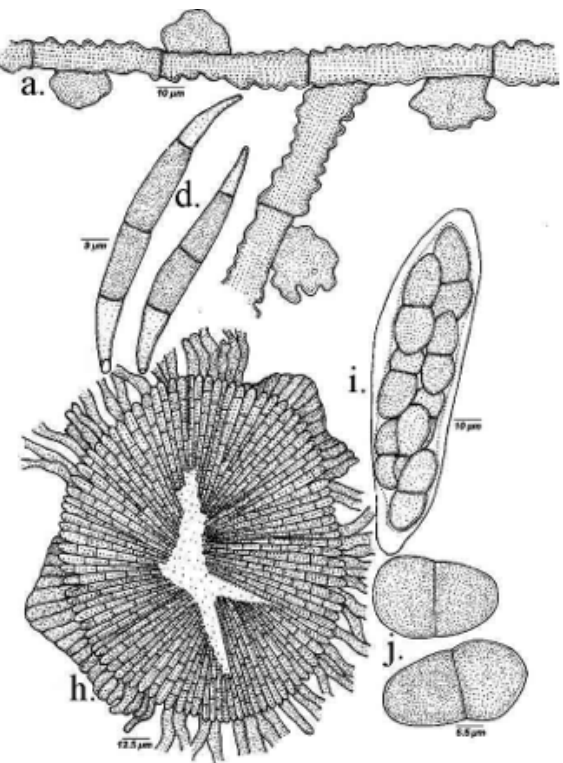
a - Appressoriate mycelium; d - Conidia of Questieriella ; h - Thyriothecium; i - Ascus; j -